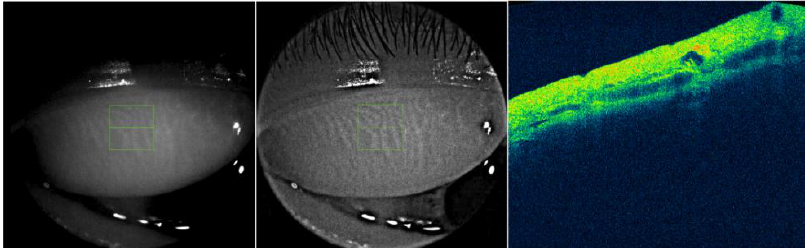
Figure 9. Fourier-domain (FD) optical coherence tomography (OCT) imaging of meibomian glands. Commercial FD-OCTs and custom-built systems can reveal the architecture of meibomian glands and their internal structure. A simple technique to obtain an infrared (IR) meibography by OCT is based on the modulation of image contrast and brightness until an adequate enhancement is achieved. An unmodified IR OCT image of the everted upper lid is displayed (left). After image processing (middle), the same enhanced image can disclose the glandular tissue in detail. Moreover, in cross-sectional OCT scans, it is also possible to detect the internal features of meibomian glands (right) [87]. Black-and-white pictures before (left) [default values of contrast and brightness = 1]) and after (right) [percentage increase in contrast = 140%, percentage decrease in brightness = 6%] image manipulation. Reflectivity of the en-face OCT image (right) [low intensity = dark / blue to high intensity = red]. Lastly, since today ophthalmologists use OCT devices routinely to image retinal structures, OCT meibography can be easily performed on a standalone